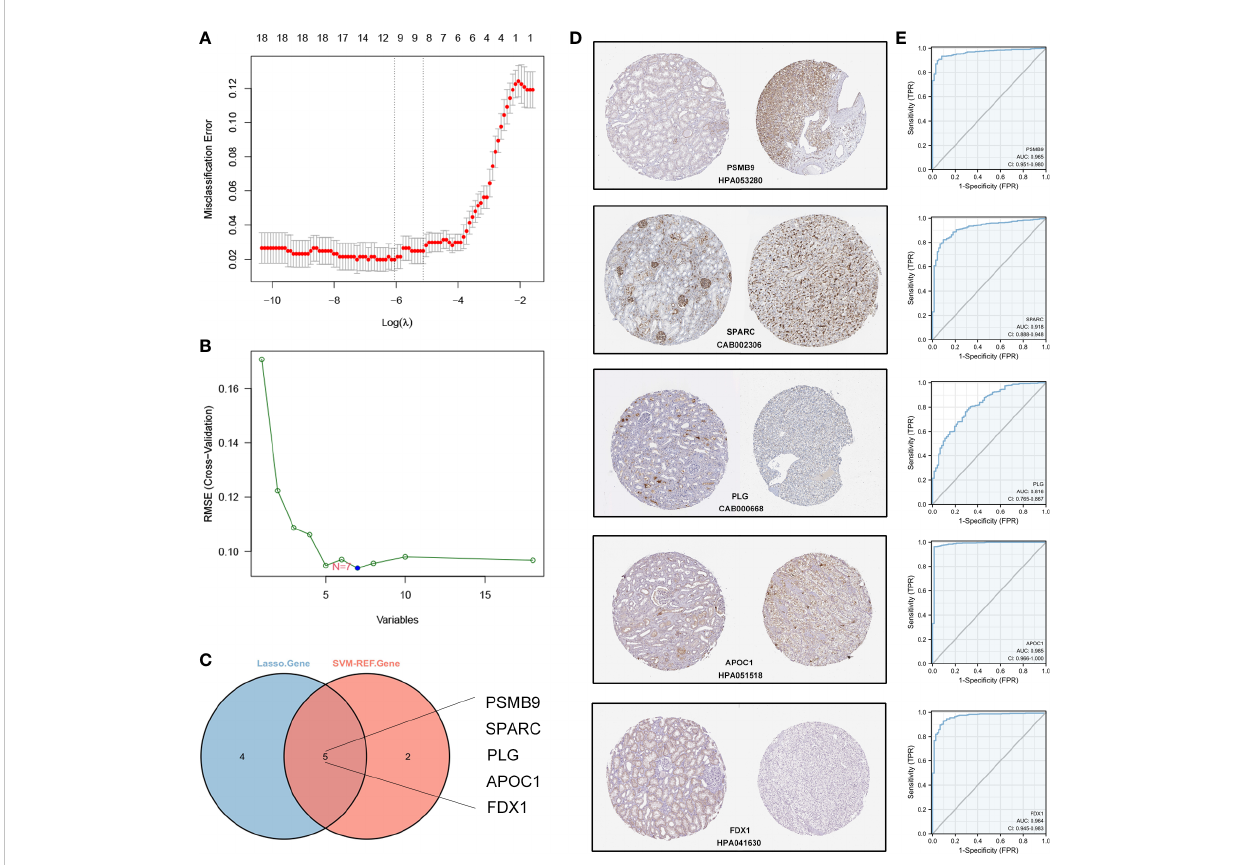
FIGURE 5 Establishment and validation of the diagnostic signature based on CRGs in TCGA cohort. (A) LASSO regression to identify signature genes in ccRCC and normal samples. (B) SVM-REF regression to identify signi fi cant CRGs in ccRCC and normal samples. (C) Venn diagram based on the intersection of the two algorithms with 5 genes. (D) The IHC-P images of 5 CRGs in HPA database. (E) ROC curves of 5 signature genes for predicting diagnostic value in TCGA